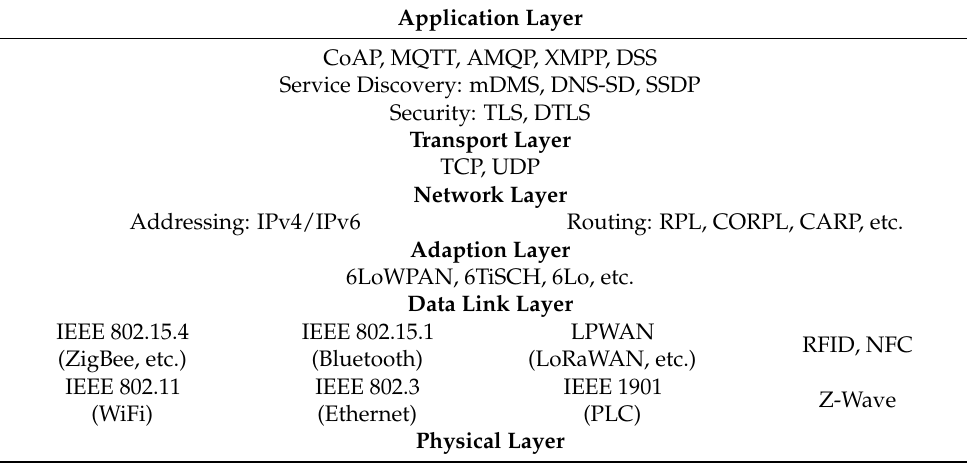
Table 2. Main protocols used in the IoT